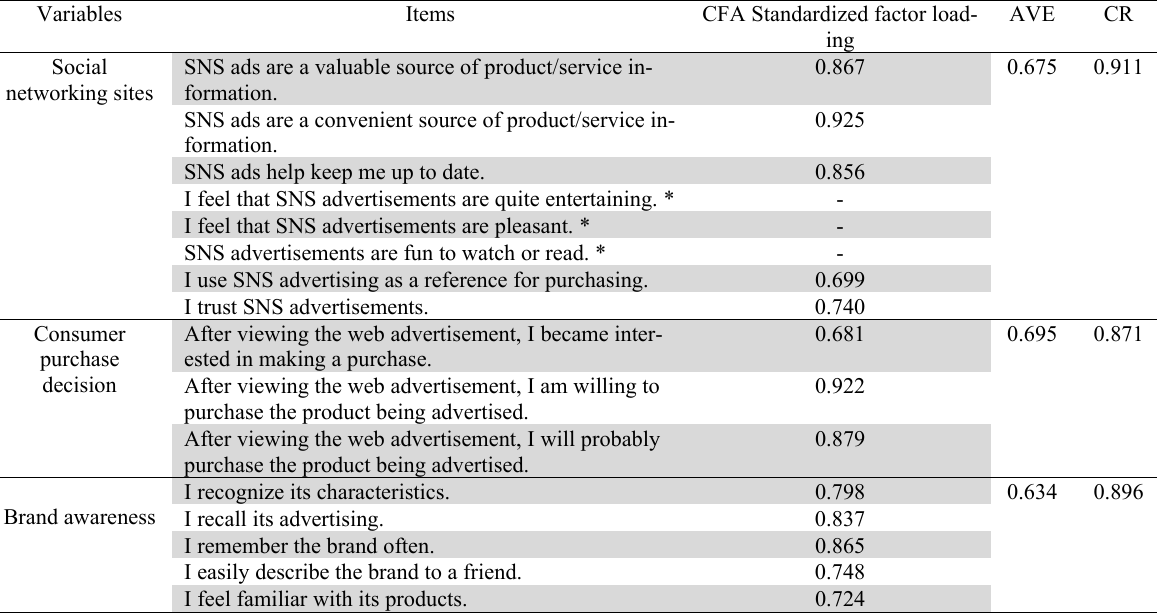
The results of CFA measurement